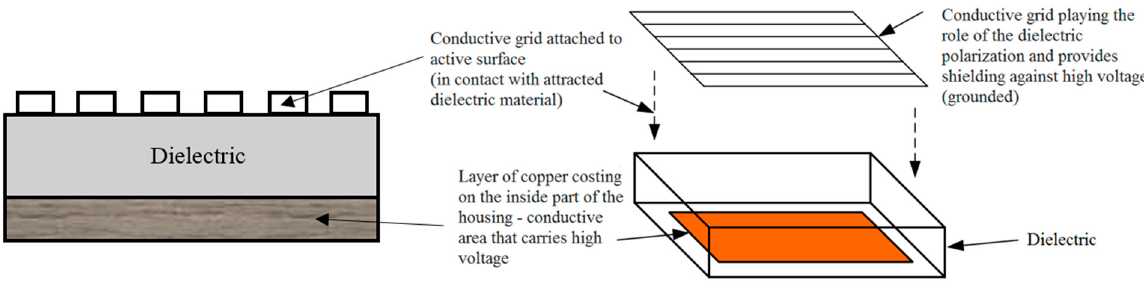
Figure 3. Design of the electroadhesive pad.